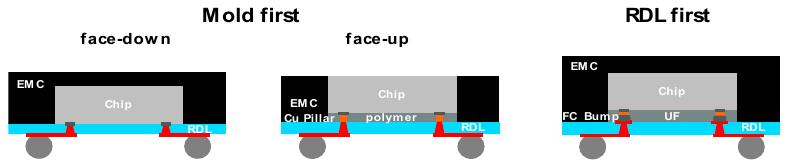
Figure 3. Fan-out wafer/panel level package structures from different process flow options.